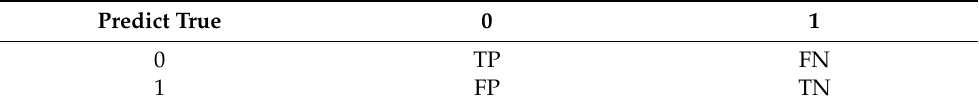
Table 4. Confusion